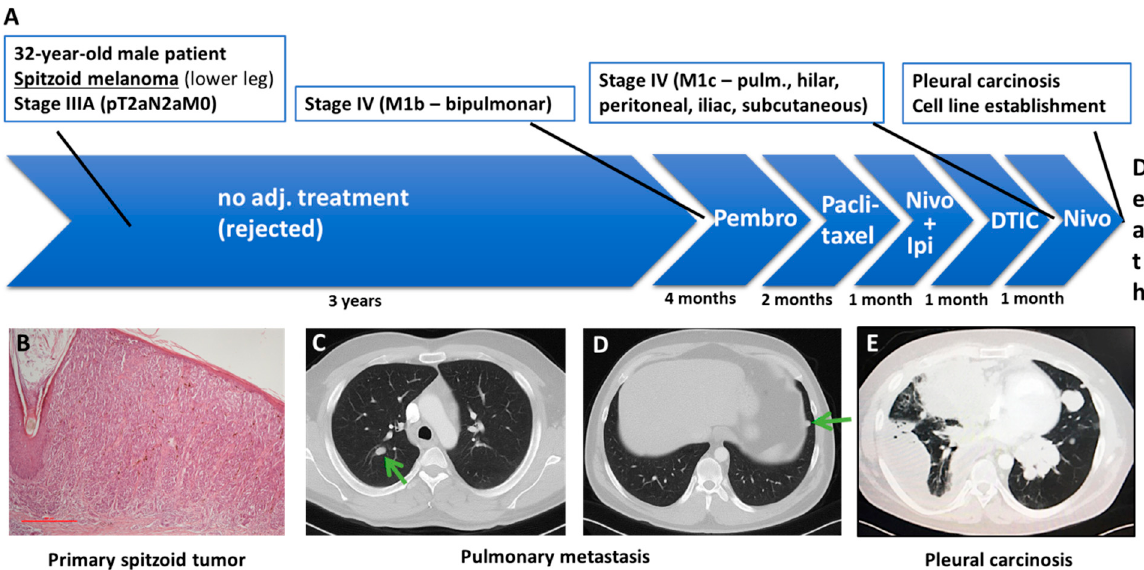
Figure 1. The patient’s treatment course. ( A ) The patient was diagnosed with a spitzoid melanoma stage IIIA (pT2aN2aM0). Three years later, bipulmonary metastases were identified. Subsequently, the patient received several lines of treatment including pembrolizumab, paclitaxel, a combination of nivolumab and ipilimumab and dacarbazine (DTIC). ( B ) Paraffin-embedded section stained with hematoxylin–eosin from the primary spitzoid tumor. The scalebar represents 500 µm. Computed tomography (CT) scans of the patient demonstrating pulmonary metastases on the right ( C ) and on the left ( D ) side of the lung. ( E ) CT scan of the patient showing pleural carcinosis and malignant pleural effusion on the right side. The PF130 cell line was established from the pleural effusion.